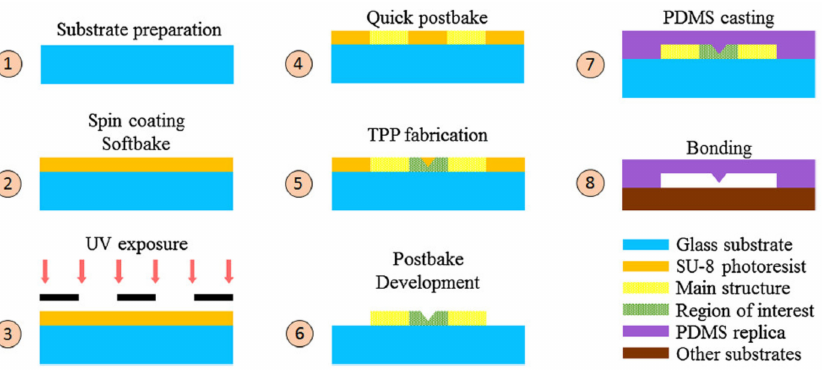
Figure 4. Illustration of a hybrid fabrication process based on photolithography and MPL. Reprinted from Ref. [71] by permission from Springer Nature: Springer-Verlag GmbH, Microfluidics and Nanofluidics Copyright